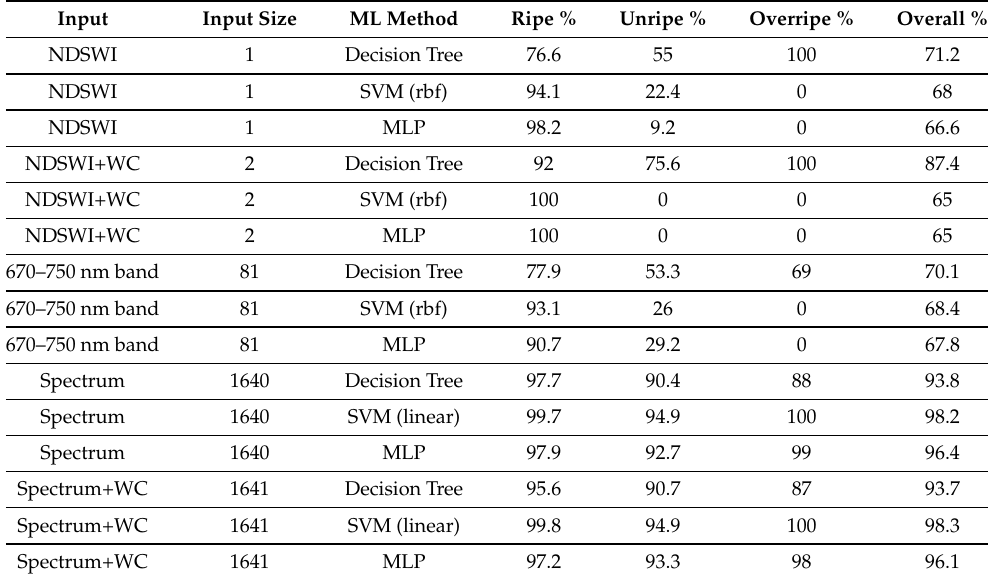
Table 1. Strawberry ripeness classification accuracy for different models and different input